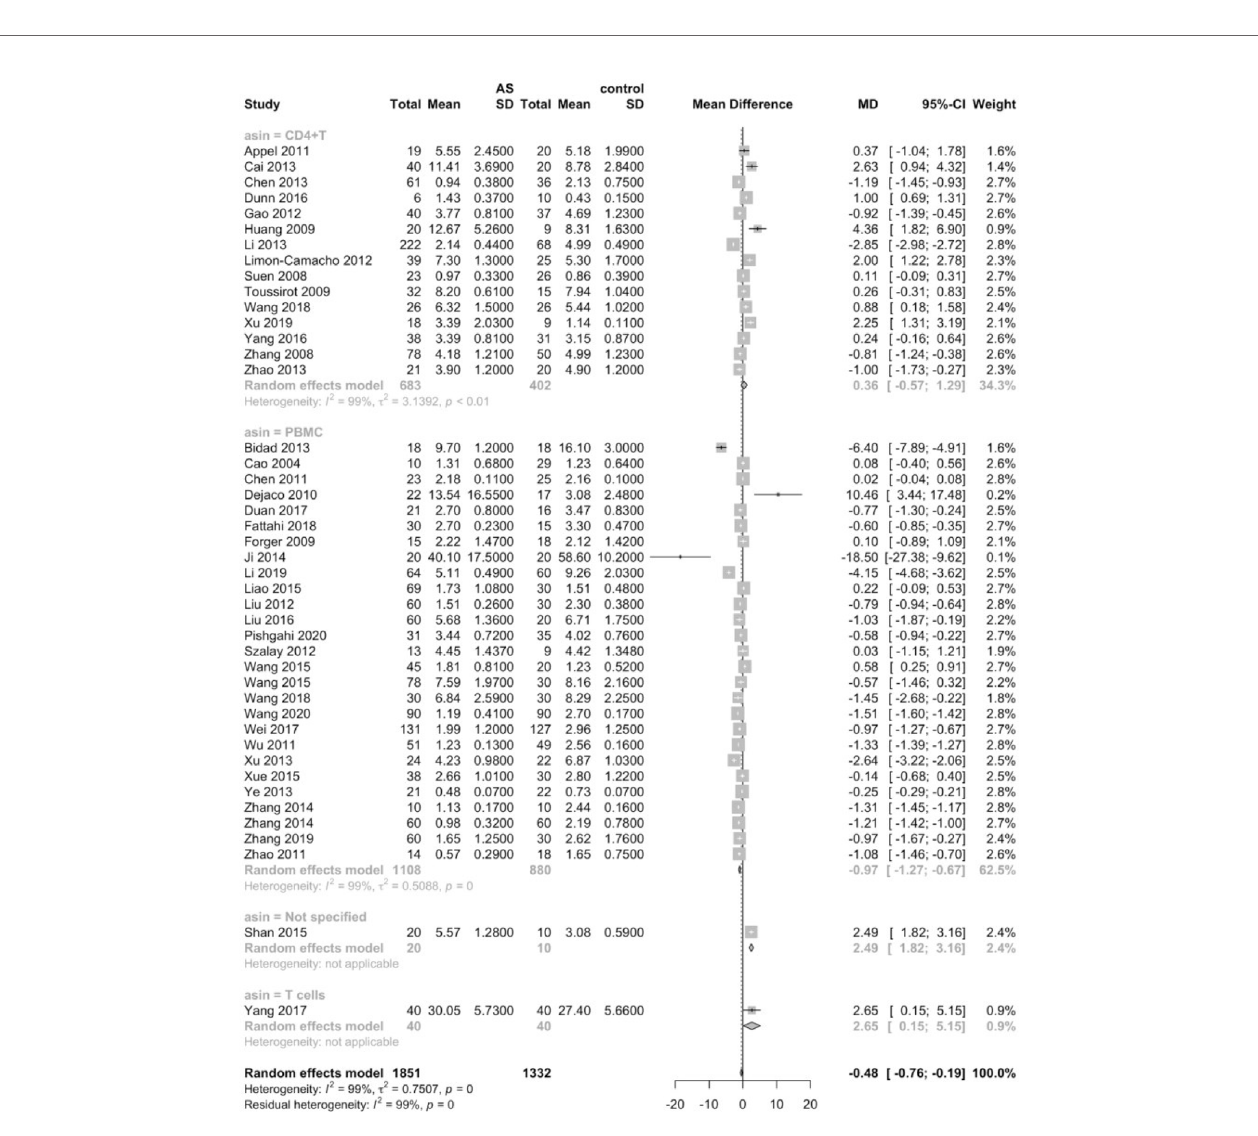
FIGURE 4 | Proportions of Tregs among PBMCs, T cells and CD4+